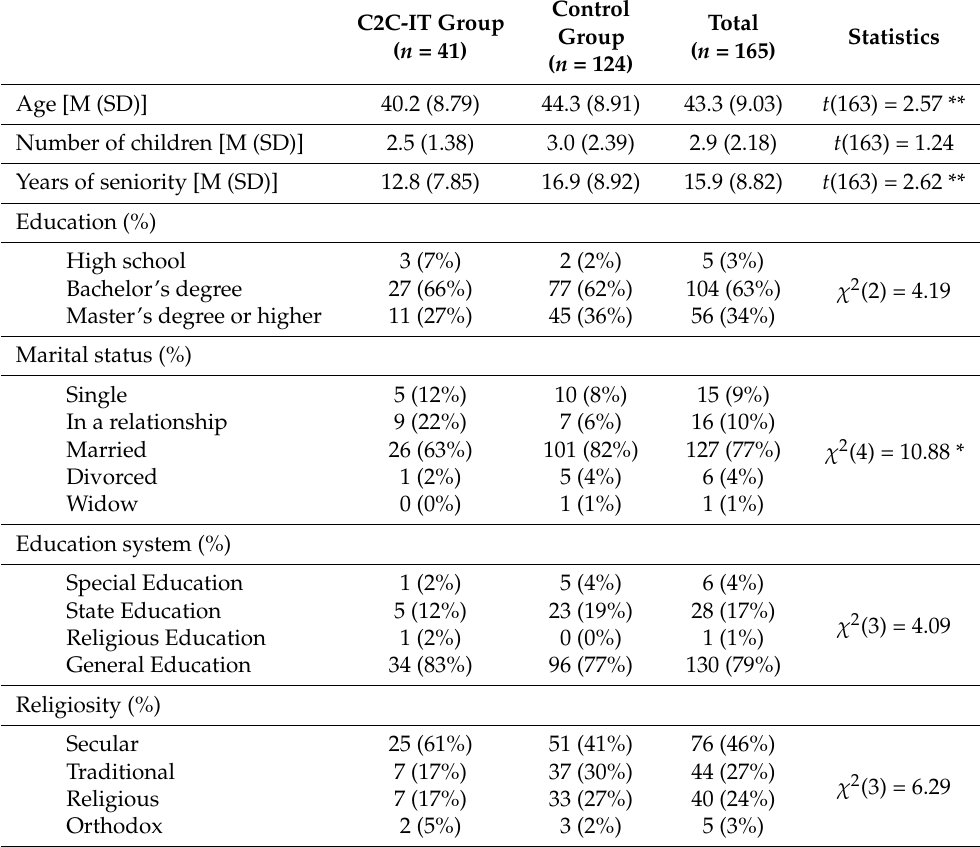
Table 1. Demographic characteristics of participants in the study (N =